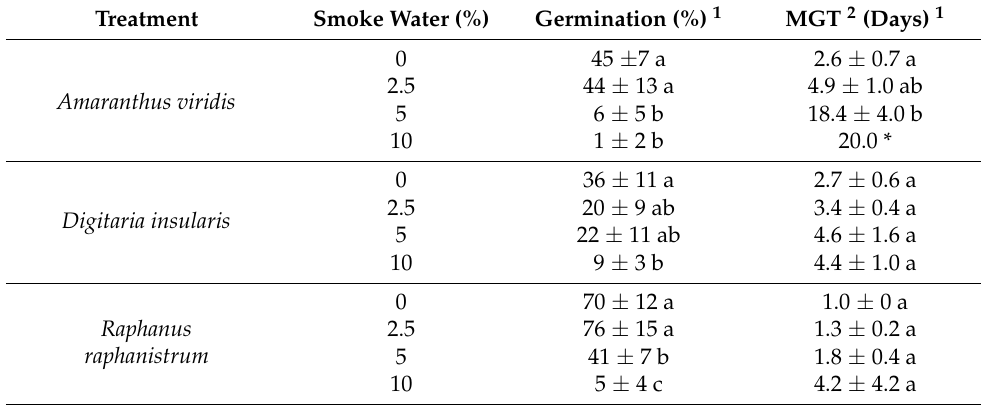
Table 1. Effect of smoke solutions on seed germination of weeds under a 12 h photoperiod at 25 ◦ C.